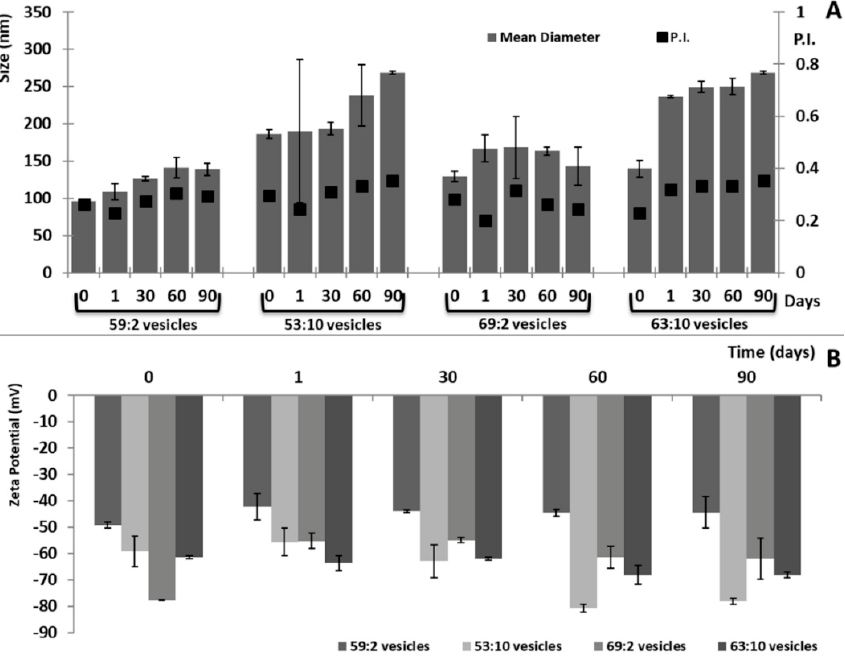
Figure 2. Values of size, polydispersity index ( A ), and zeta potential ( B ) of clotrimazole loaded three-dimensionally-structured hybrid vesicles collected over 90 days of storage at 25 ± 1 °C. Mean values ± standard deviation (error bars) were reported from six independent samples.